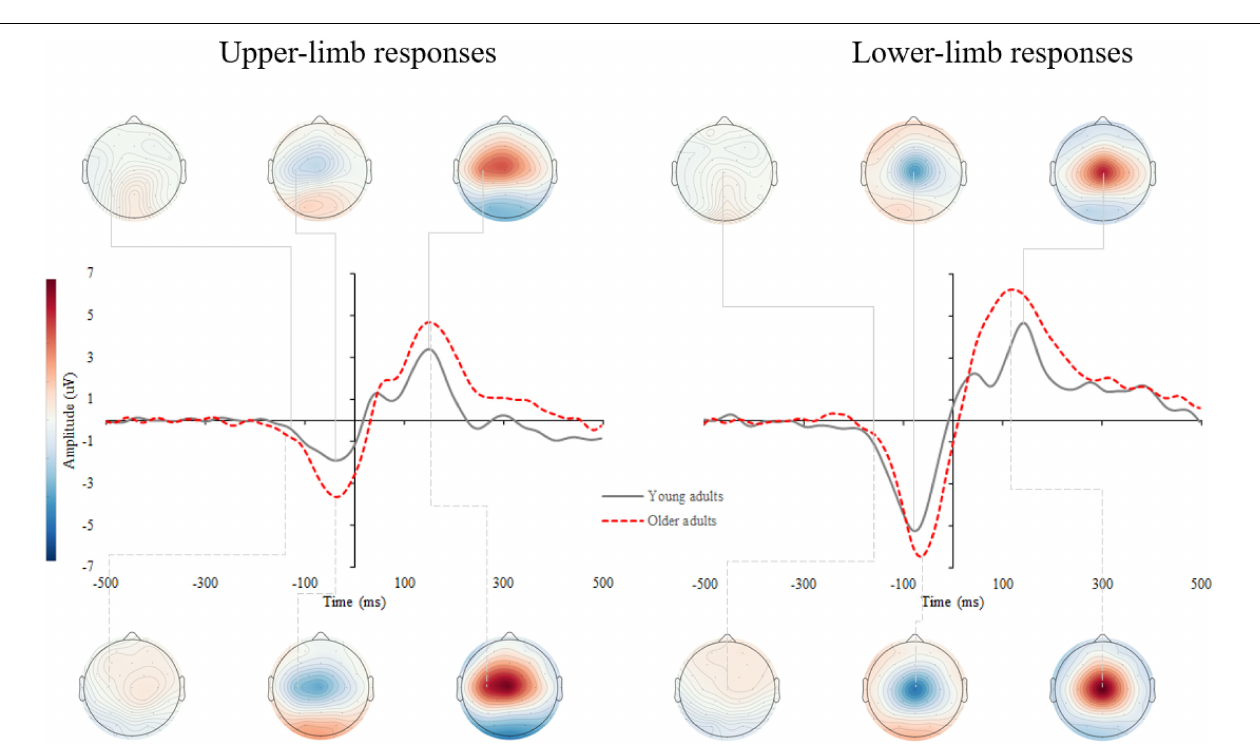
FIGURE 6 | Grand average response-locked event-related potentials (r-ERPs) for upper- (left) and lower-limb RT (right) for younger and older adults. The topographic maps correspond to the individual MRCP components: onset latency, peak amplitude, and movement-monitoring potential.